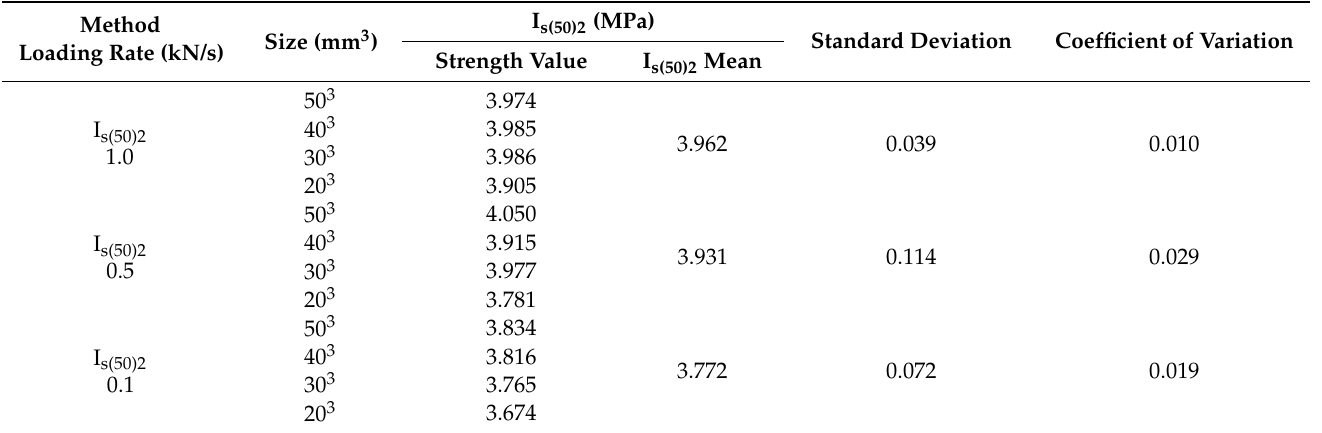
Table 7. Statistical table listing the variability of I s(50)2 for siltstone with different sizes and loading